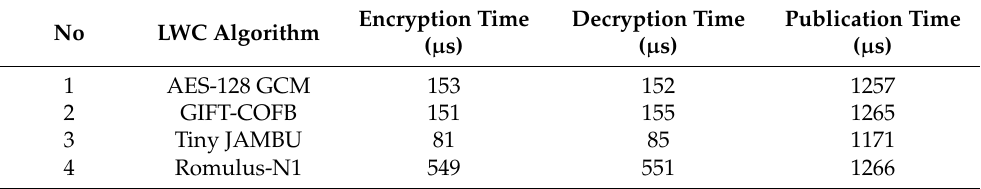
Table 13. Lightweight Cryptographic Encryption and Decryption Performance on STM32L4 with 15 Characters Messages Used Registered Account.